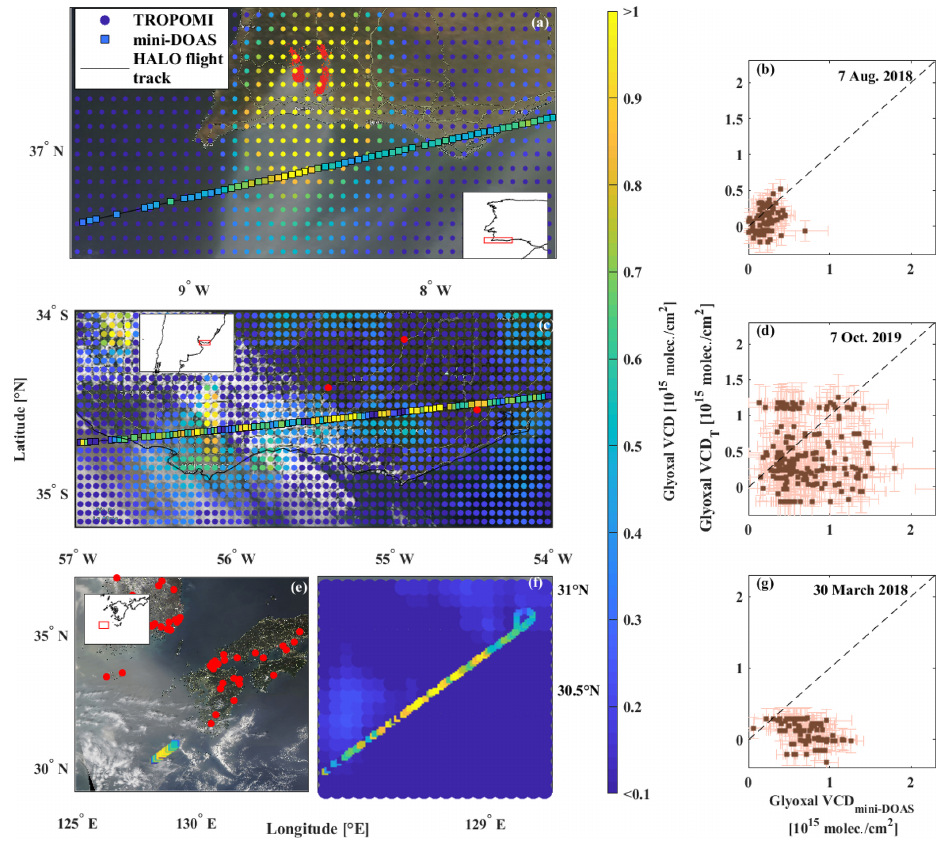
Figure 9. Collocated glyoxal VCDs from mini-DOAS observations (diamonds with black contours) and 0.25 ◦ × 0.25 ◦ resolution L3 TROPOMI observations (squares) in different regions (a, c, e, f) , with corresponding scatterplots (b, d, g) , where each TROPOMI ob- servation is gridded around the mini-DOAS measurements, as shown in Fig. 8b. For better visibility of the underlying satellite image, the footprints are not to scale. (a, b) Monitoring of a glyoxal plume from wildfires in the Serra de Monchique (Algarve, Portugal) detected by TROPOMI and by the mini-DOAS instrument (13km flight altitude) over the Gulf of Cádiz at 13:50 and 11:00UTC, respectively, on 7 August 2018. (c, d) Overpass of extended biomass burning plumes near the Uruguayan coast region observed by TROPOMI (overpass at 17:00UTC) and mini-DOAS (8–13km flight altitude) at 10:45UTC on 7 October 2019. (e, f, g) Monitoring of a glyoxal plume within the marine boundary layer above the East China Sea, southwest of Japan, on 30 March 2018 at 12:50UTC (TROPOMI) and 01:40UTC (mini- DOAS) with the geographic overview (e) , magnification of the flight track (f) , and respective scatterplot (g) . The wildfire data (red circles; not to scale) are derived from MCD14 MODIS observations on the Terra and Aqua satellites. The MODIS satellite images are taken from NASA Worldview, based on the satellite overpasses on 13:48UTC on 7 August 2018 (a) , 17:23UTC on 7 October 2019 (c) , and 02:30UTC on 30 March 2018 (e)